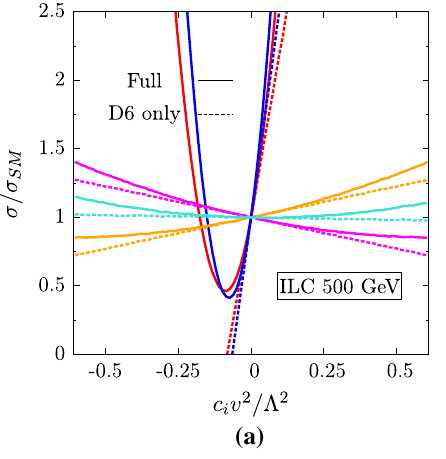
√ s = 500 fromtheinterferenceterm,andthe solidlines showthefulldependence. The operator colour coding is the same as Fig. 1. b Likewise for CLIC √ s = 3 running at